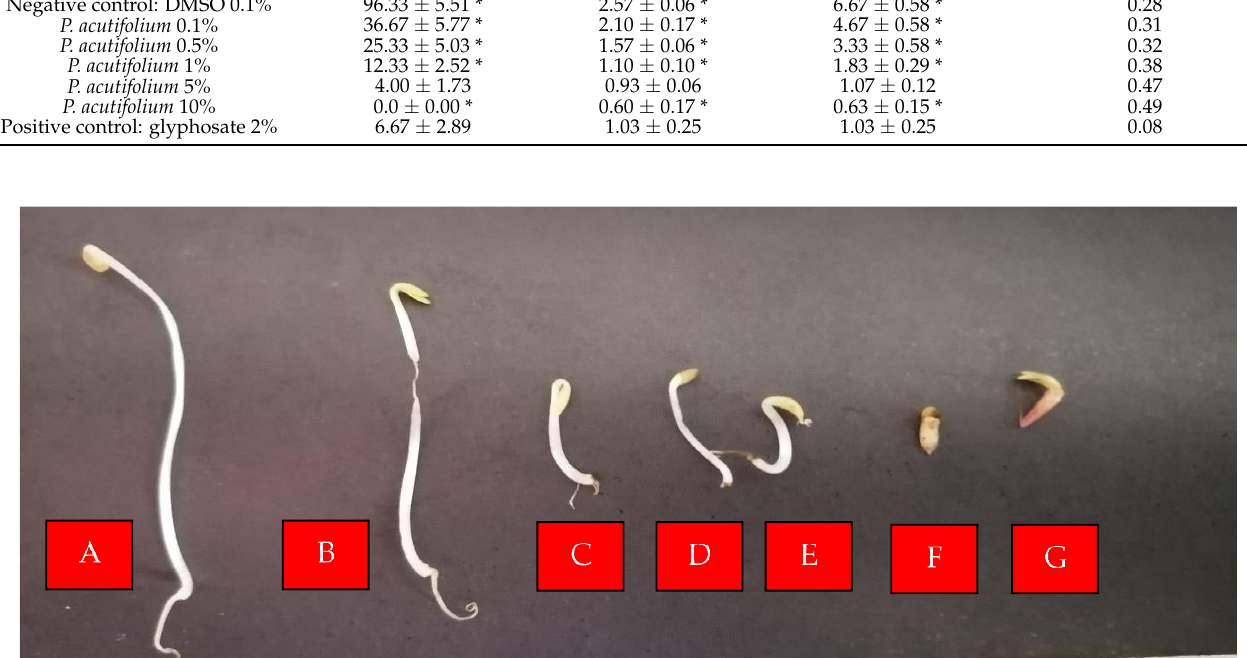
Figure 1. Phytotoxic activity of the essential oil of P. acutifolium on Lactuca sativa seeds. A: Negative control (DMSO 0.1%); B: P. acutifolium 0.1%; C: P. acutifolium 0.5%; D: P. acutifolium 1%; E: P. acutifolium 5%; F: P. acutifolium 10%; G: Glyphosate